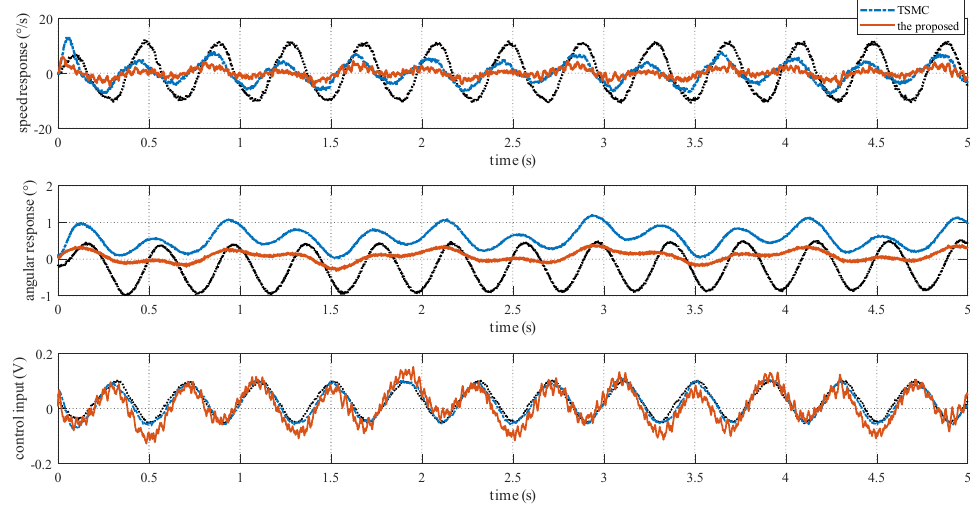
Figure 16. Experimental response curves under Case